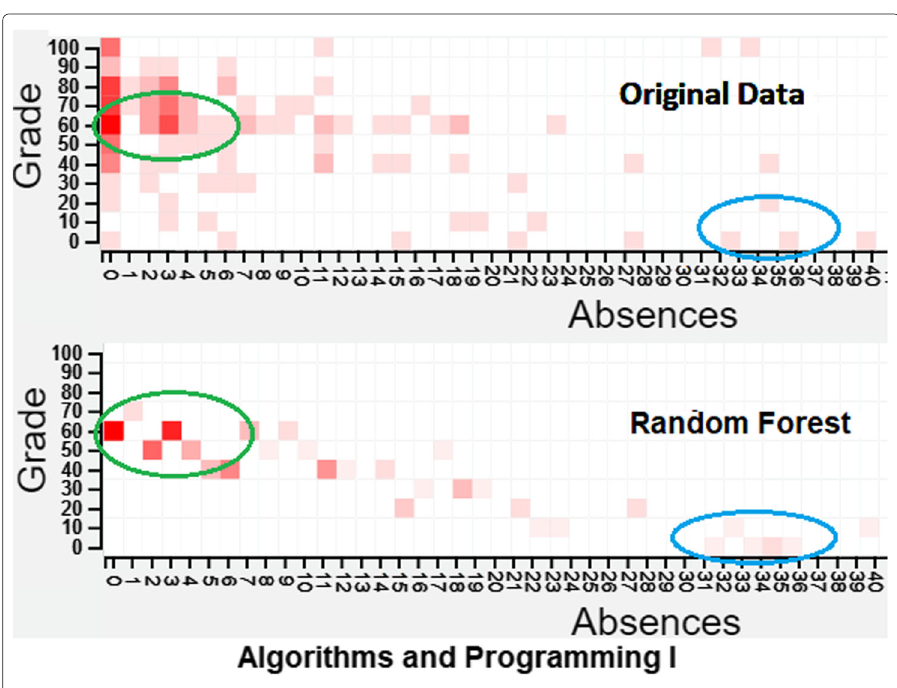
Fig. 12 Algorithms and Programming I: Original data vs. Random Forest prediction show that SVR and Random forest made more accurate predictions for "Algorithms and Programming I" course compared to all other methods.